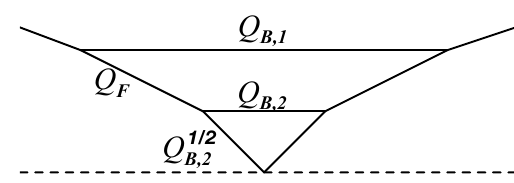
Figure 25 . Parametrization for the 5-brane web with O 5 -plane for the pure Sp(1) gauge theory.